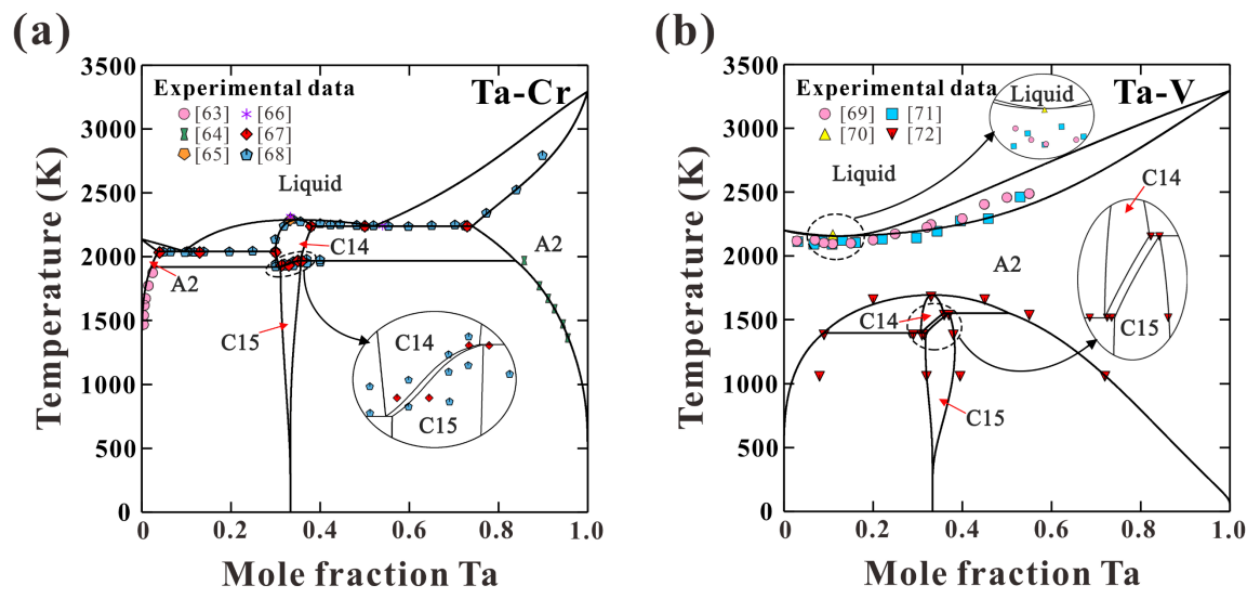
Figure 3. Calculated phase diagrams for ( a ) Ta-Cr and ( b ) Ta-V binary systems along with experi- mental data [63–72]. Table 3. Calculated temperatures and compositions of invariant reactions in Ta-Cr and Ta-V